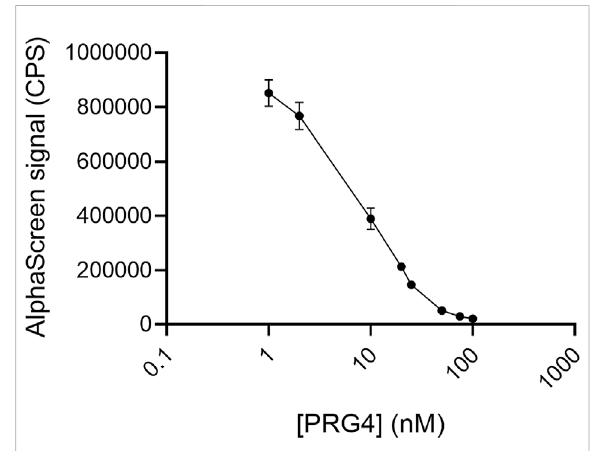
FIGURE 7 PRG4 competes with HA for binding to TSG-6. In the AlphaScreen experiments, end-biotinylated HA at 0.2 nM fi nal chainconcentrationwasincubatedtogetherwithTSG-6proteinat 14 nM fi nal concentration, and increasing concentrations of PRG4 in free solution, then mixed with streptavidin-coated donor and nickel chelate-coated acceptor beads for detection of HA- TSG-6 direct binding. Signal was recorded as counts per second (CPS). Each experiment was repeated at least three independent times, and a representative experiment is shown. Each data point represents the mean ± standard deviation from triplicate